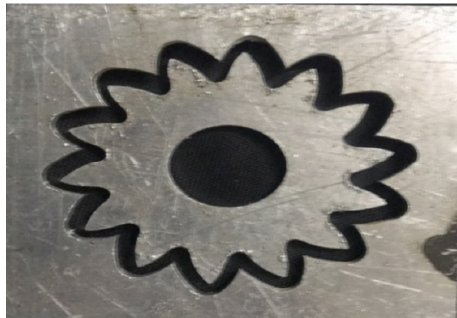
Fig. 10. Transfer of g-code to machine.